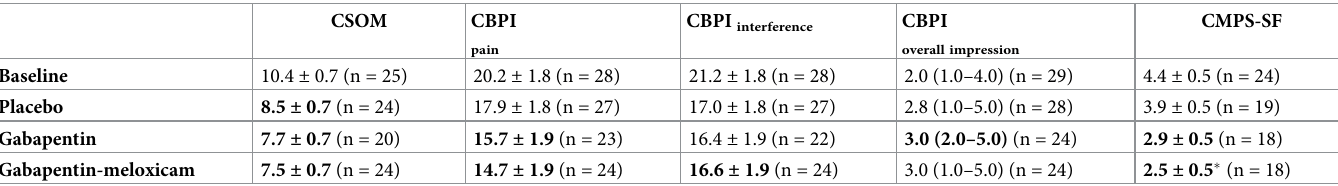
Table 3. Pain scores obtained in dogs with naturally-occurring neuropathic pain before and after each treatment period. Data are presented as mean ± SEM for scores from Client Specific Outcome Measures (CSOM), Canine Brief Pain Inventory (CBPI pain and CBPI interference ), and short-form Glasgow Composite Measure Pain Scale (CMPS-SF). Data are presented as median (range) for scores from CBPI overall impression .